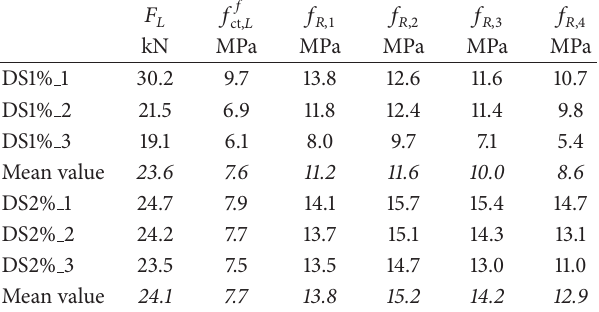
Table 6: Three-point bending tests: tensile strength